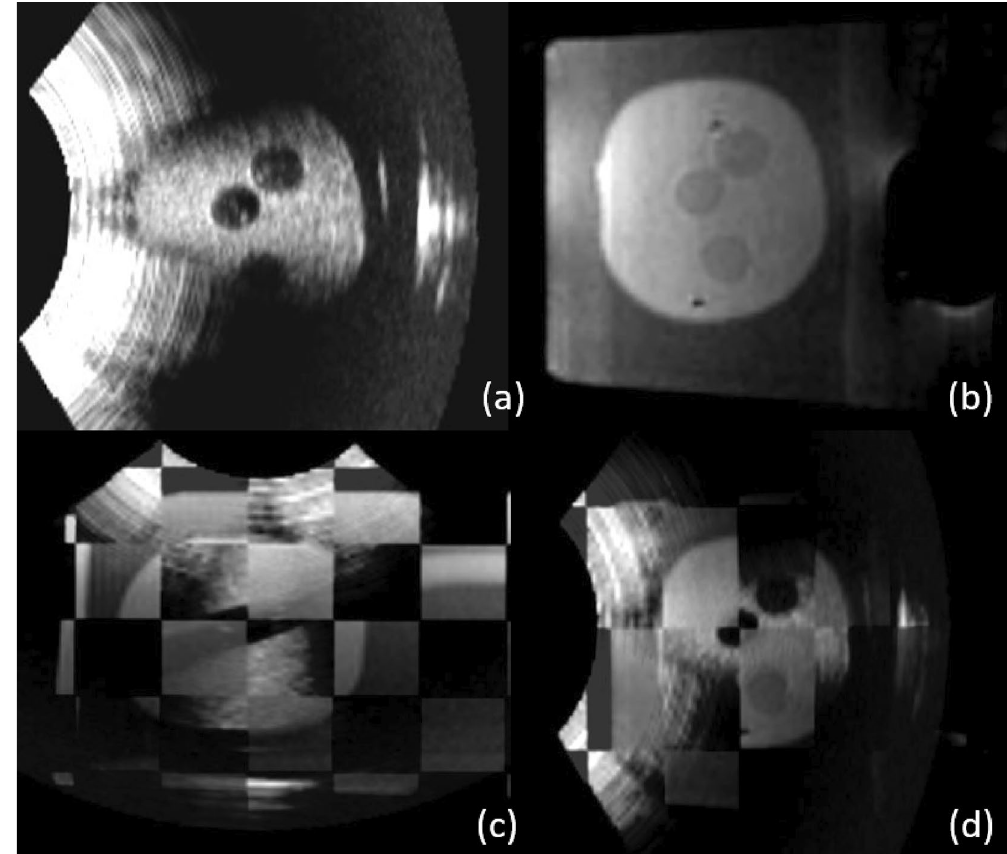
Figure 7. Sagittal views of the prostate phantom images from the ab-3D-US ( a , b ) and from the MR ( b ). Checkerboard images from from the coronal ( c ) and sagittal plane ( d ) from the registered MRI and ab-3D-US images of the prostate phantom. From this registration the Dice score was calculated from the segmented